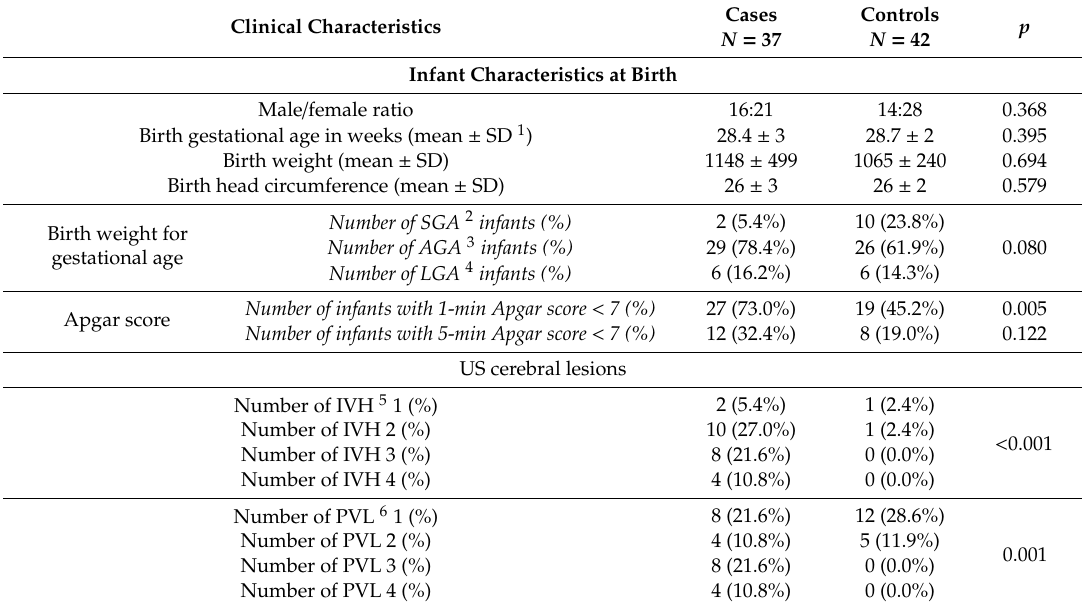
Table 3. Clinical